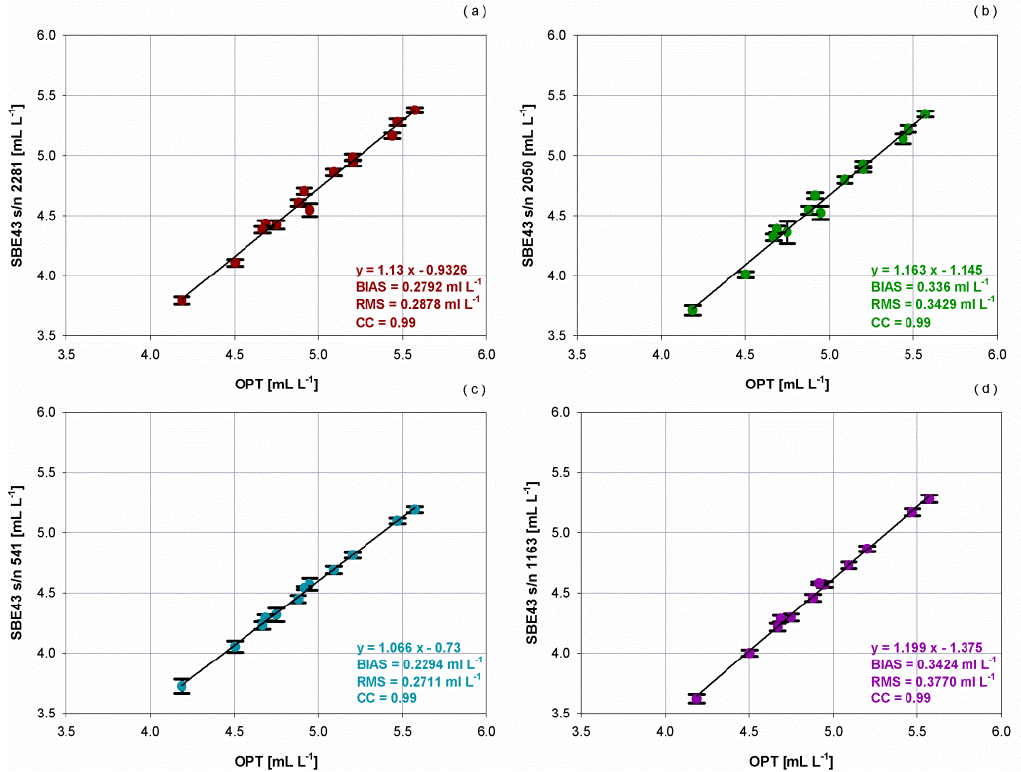
Figure 9. Dispersion diagrams of OPT against the SBE43 sensors ( a ) s/n 2281, ( b ) s/n 2050, ( c ) s/n 541, ( d ) s/n 1163 before (full dot) and after (empty square) the SOC correction. Error bars correspond to five times’ the measured standard deviation.